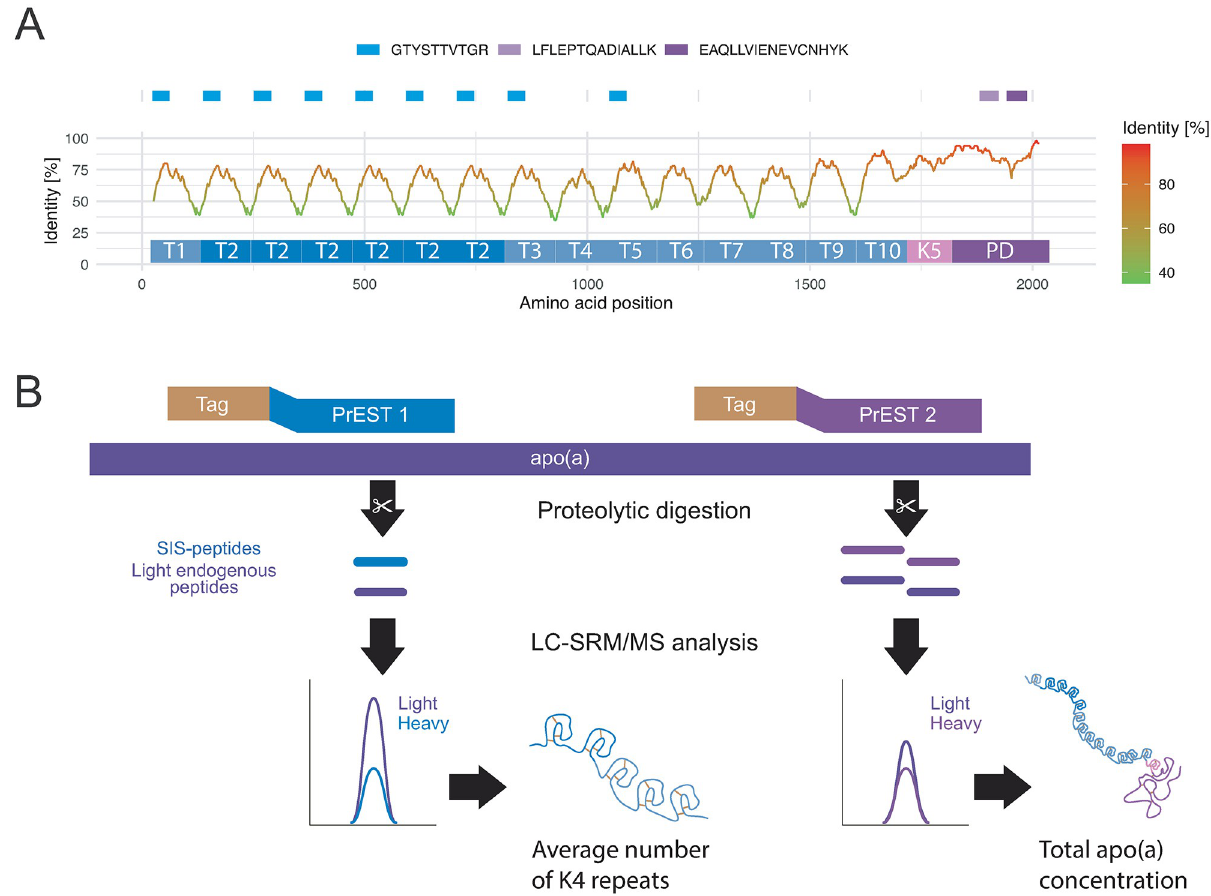
Fig 1. A) Visualization of the homology of apo(a) to other human proteins plotted as identity based on HsID50 and the transcript ENSP00000321334 (red = high, green = low). T1-T10 is used to denote the K4 domains and PD designates the plasminogen domain. Three different SIS PrEST peptides are mapped to the sequence at the top. B) A schematic visualization of how the SIS PrESTs are used to determine the number of K4 domains following quantification of total apo(a) and the K4 domain upon proteolytic digestion. One SIS PrEST is used to determine the molar concentration of peptides mapping to the K4 domains and one SIS PrEST is used to determine the molar concentration of apo(a). The ratio between the concentration from the K4 domain and the molar concentration of apo(a) corresponds to the number of K4